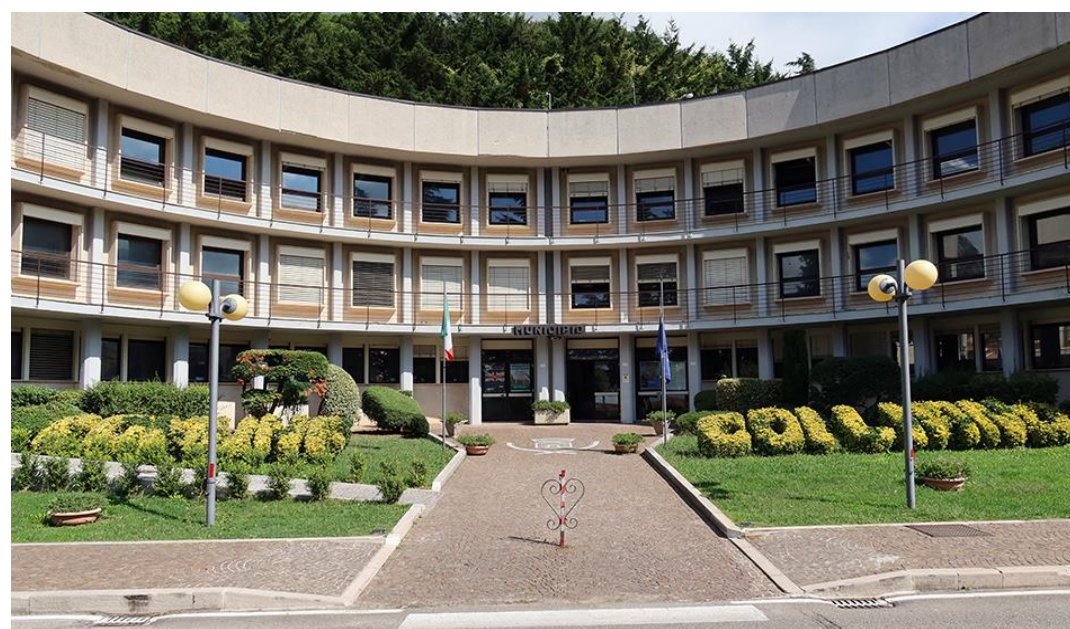
Figure 80. Colliano: the new Town Hall of the village (photos by [35,36]).